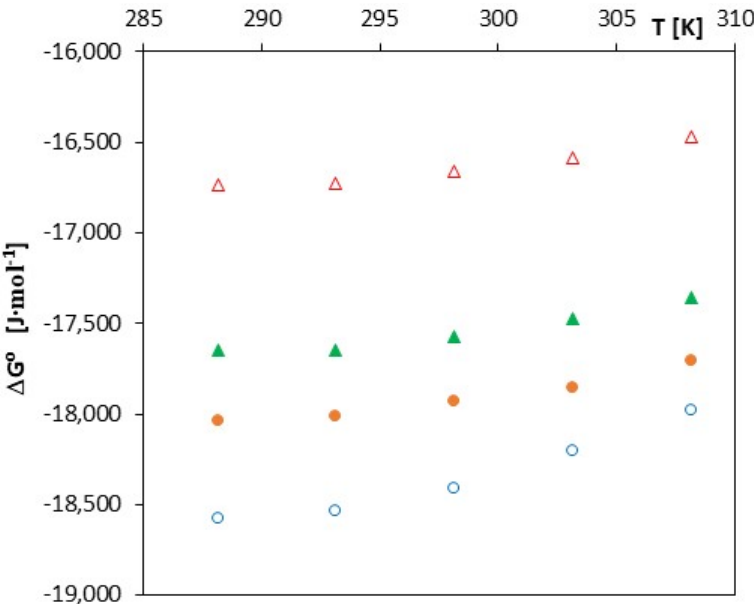
Figure 4. The plots of dependence of Δ𝐺 (cid:3042) (J ∙ mol − 1 ) in the function T (K) for α -cyclodextrin with all studied salts: ∆ - trans -cinnamic acid; ▲ - trans - p -coumaric acid; ● - trans -caffeic acid; and ○ - trans - ferulic